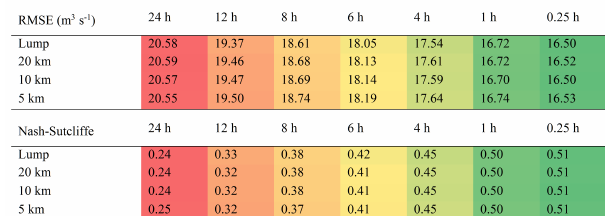
Table 7. Hydrological performance statistics from the Upper Swale catchment, comparing daily discharges from the CAESAR-Lisflood model and observed daily discharges recorded from Catterick Bridge. Red shading indicates the worst performance statistics and the green the best performance statistics.